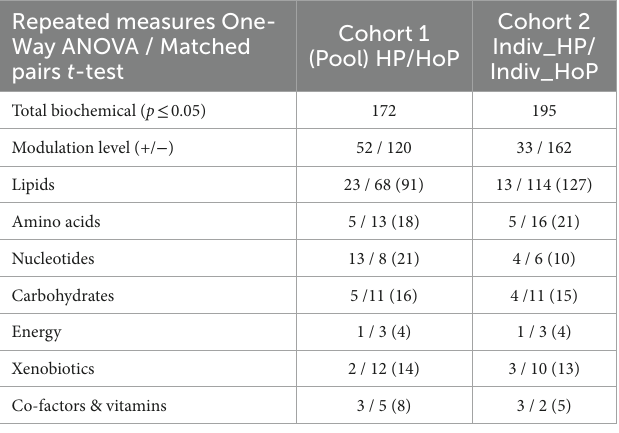
TABLE 2 Differential effect of HoP and HP processing on the human milk metabolome. Repeated measures One- Way ANOVA / Matched pairs t -test